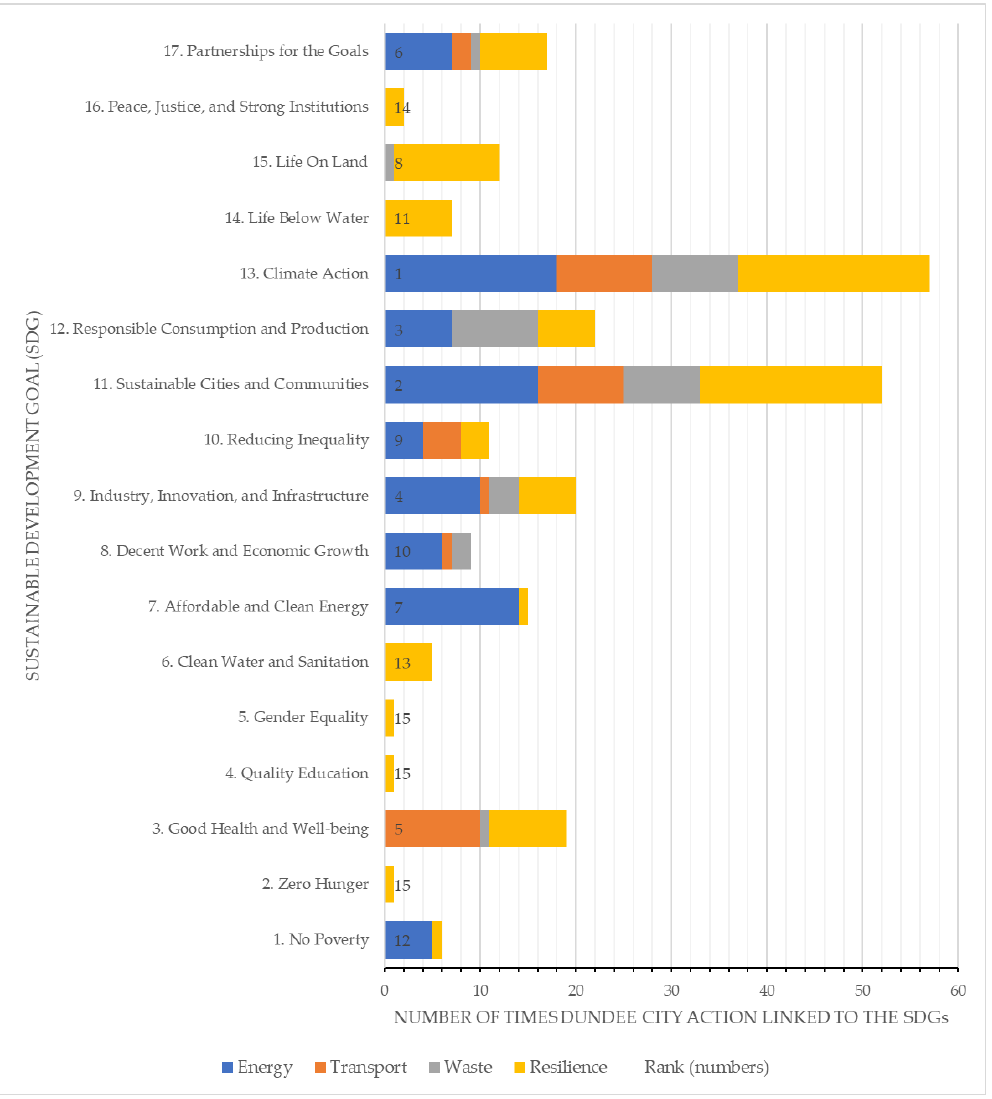
Figure 6. Frequency of linkage of Dundee’s energy-, transport-, waste- and resilience-themed actions to the SDGs (source: authors’ analysis of Dundee’s identified actions in the Dundee Climate Action Plan [24]).